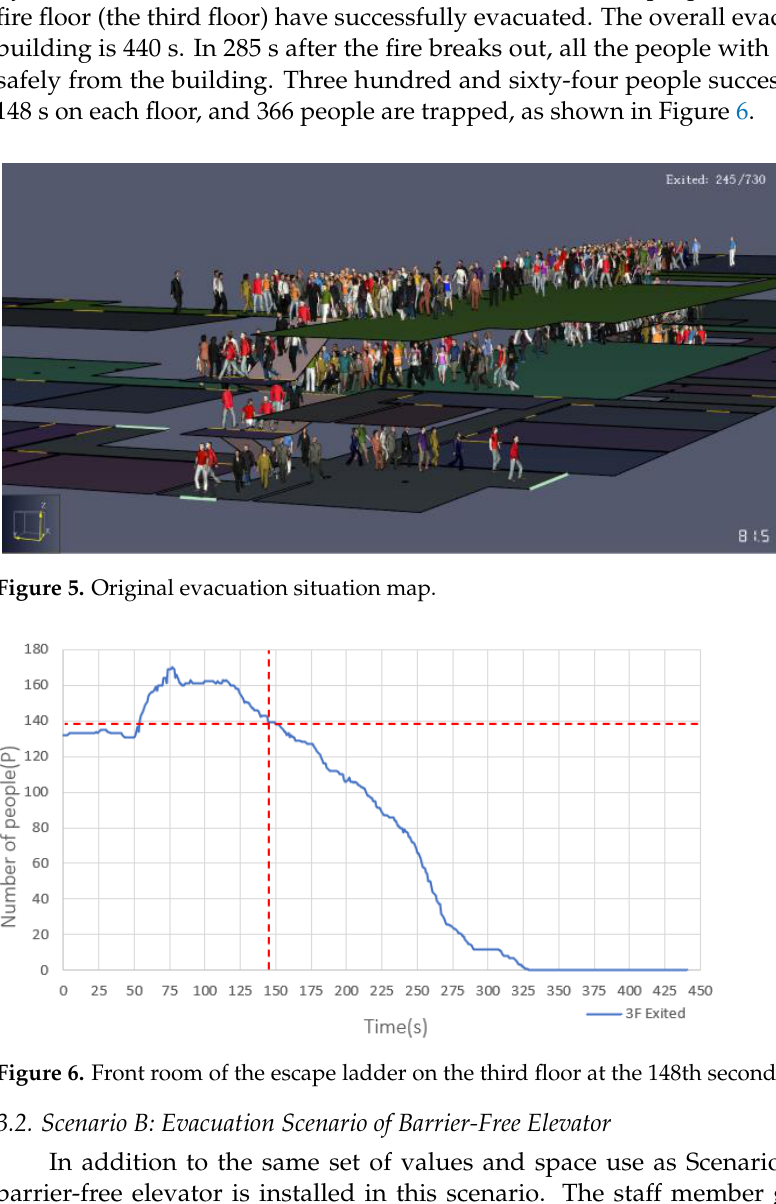
Figure 4. External ramp evaluation configuration diagram in Scenario C.